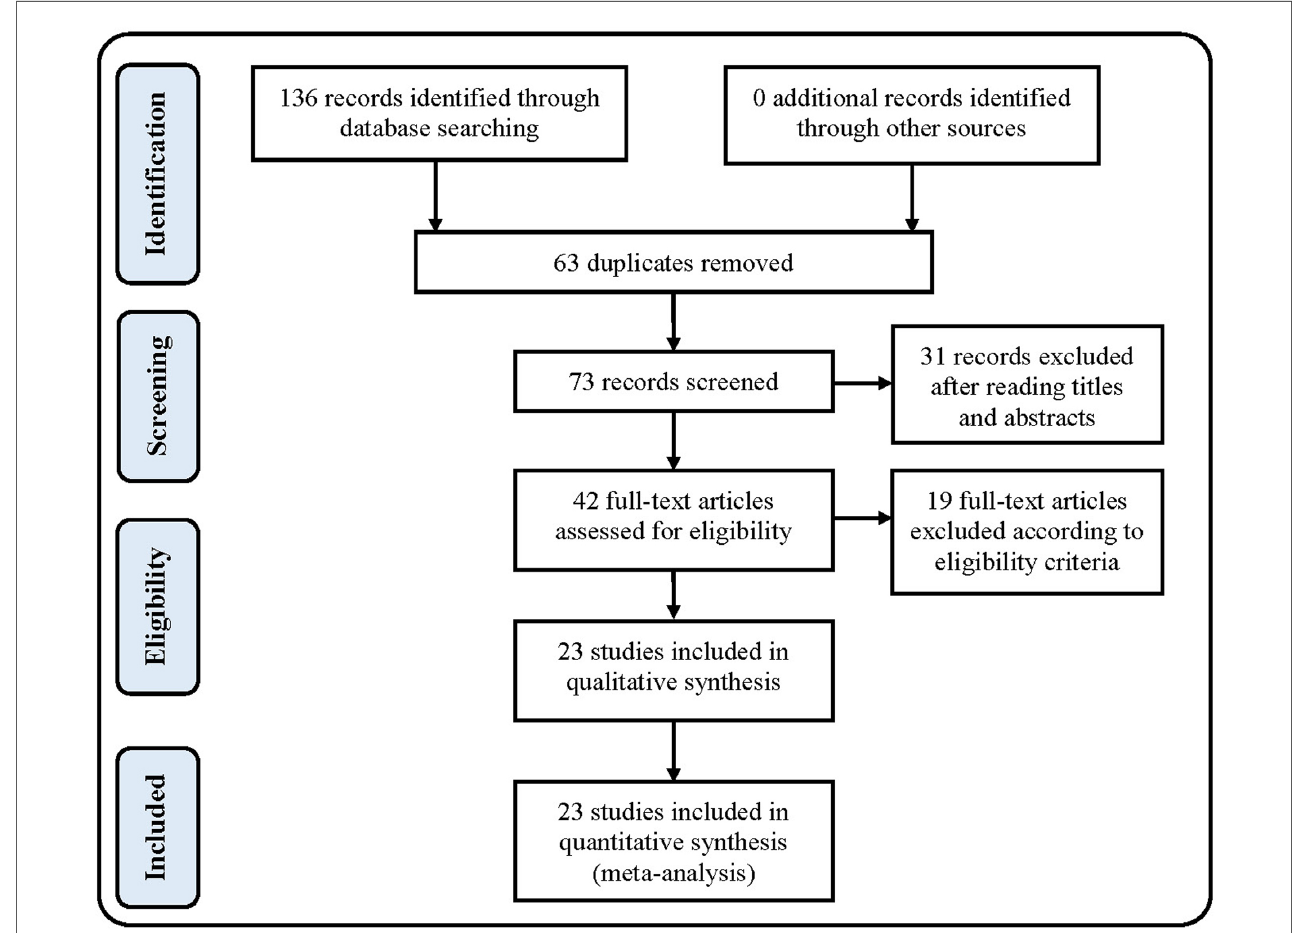
FIGURE 1 Flow chart of screened